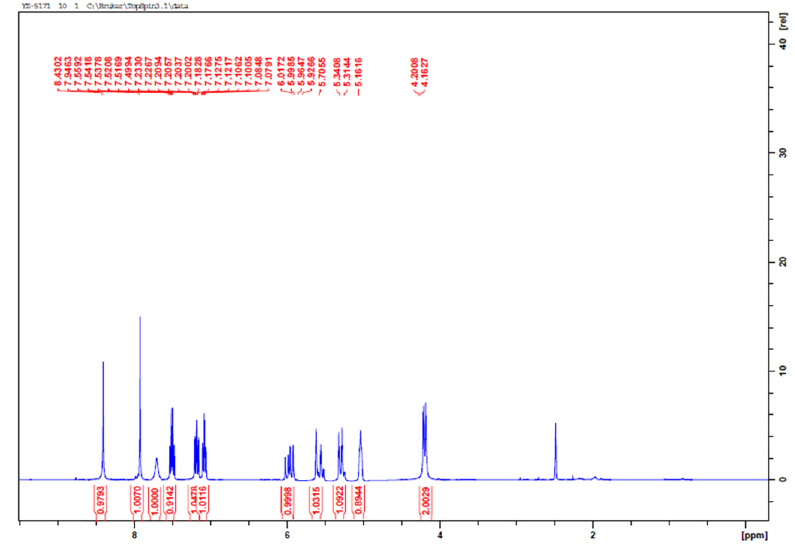
Figure A3: 1 H NMR spectra of compound 3.